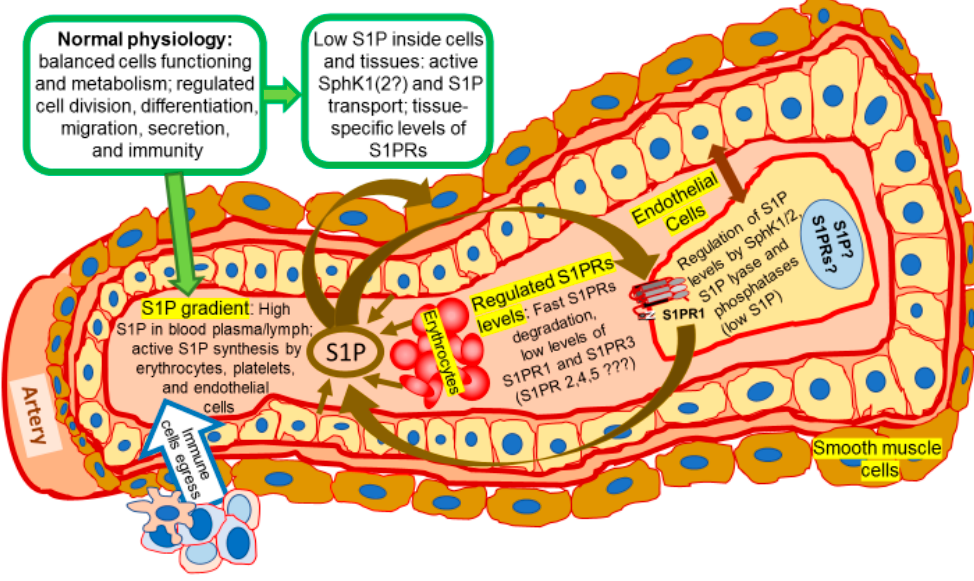
Figure 1. Normal physiology: the place of sphingolipid signaling pathway. A transverse cut through the artery shows an inside space of the blood vessel filled with blood plasma and blood cells (only erythrocytes are shown), as well as a layer of endothelial cells surrounded by smooth muscle cells. Endothelial cell layer and enlarged single endothelial cell are indicated by a double-ended arrow. Coordinated sphingolipid signaling creates a favorable environment for normal physiological functioning. The activity and expression levels of sphingosine kinases (SphK), sphingosine-1-phosphate (S1P) and its receptors (S1PRs) are maintained at normally low tissue specific levels required for healthy metabolism. Alternatively, high concentration of S1P in blood plasma (and lymph) is supported by release of S1P from endothelial cells, erythrocytes, and platelets. Binding of S1P to S1PRs stimulates activation of an appropriate signaling in cytoplasm and gene activation in nucleus that are followed by quick S1PRs internalization, degradation, and re-cycling. Activation of endogenous SphK by hormones, cytokines, and growth factors results in reduction of sphingosine cell content and production of S1P. S1P/S1PRs axis activates further downstream signaling targets and controls variety of physiological processes including lymphocyte egress from lymphoid organs [5,8,9,14,17,21,62–68]. Arrows indicate the movement of S1P and direction of its effects (such as activation of S1PR by S1P as ligand, release of S1P by endothelial or cancer cells, etc.). The arrow directed from S1P to the endothelial cell indicates that S1P also activates endothelial cell signaling via S1PRs. Question marks indicate the gaps in our knowledge of SphK/S1P/S1PRs axis.